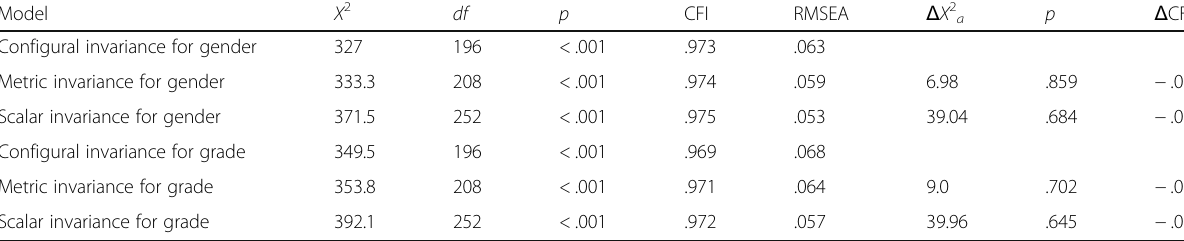
Table 3 Fit indices for invariance test of the four-factor model (16 items) Model X 2 df p CFI Configural invariance for gender Metric invariance for gender Scalar invariance for gender Configural invariance for grade Metric invariance for grade Scalar invariance for grade